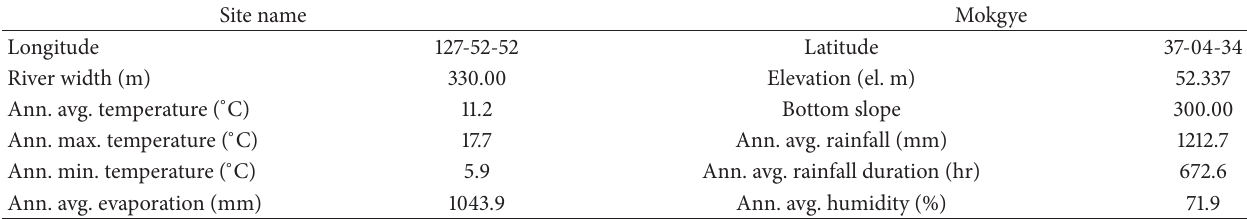
Table 2: Mokgye site characteristics.